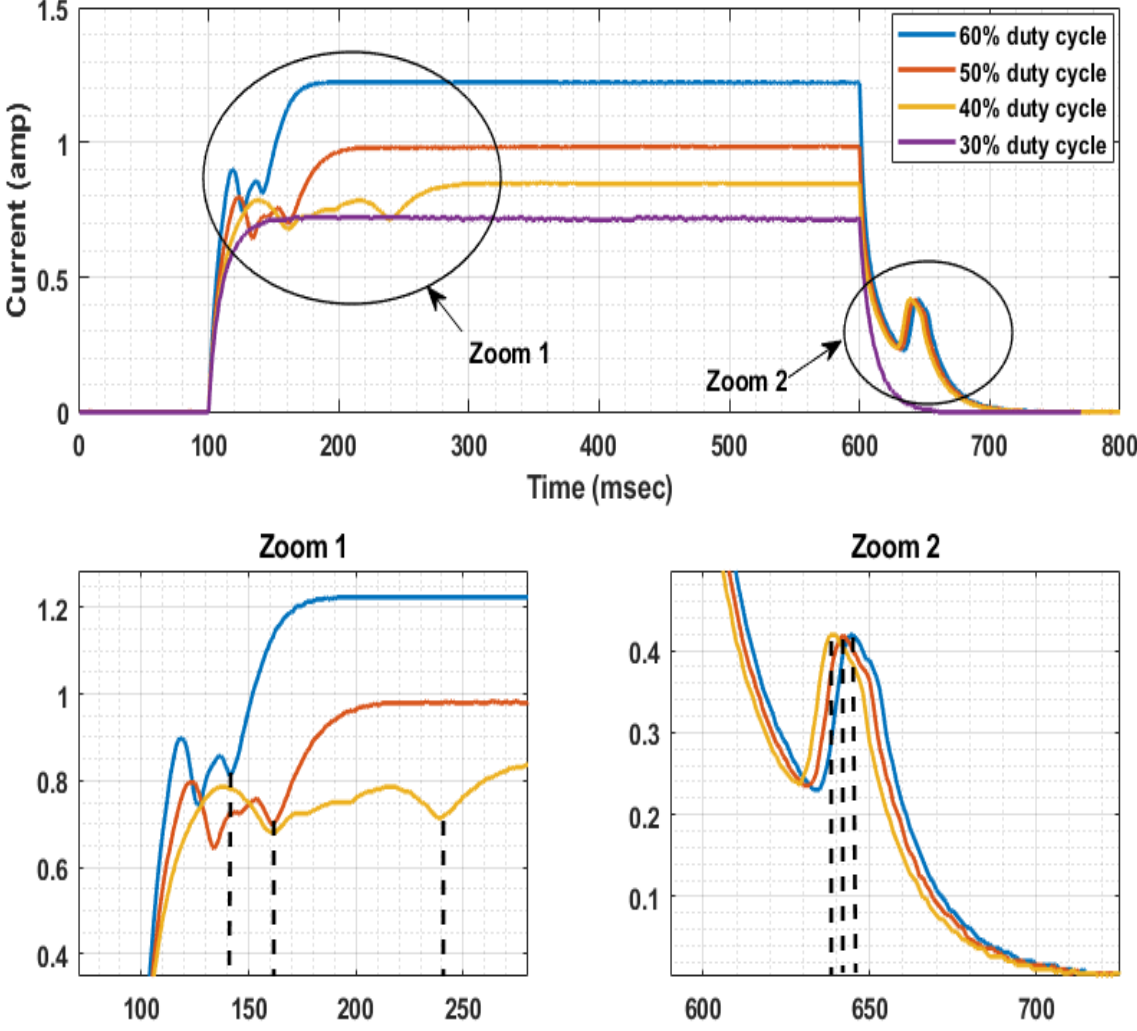
Figure 11. Solenoid current when the solenoid is excited for 0.5 sec by a signal of frequency 1 kHz and different duty cycles (60%, 50%, 40%, and